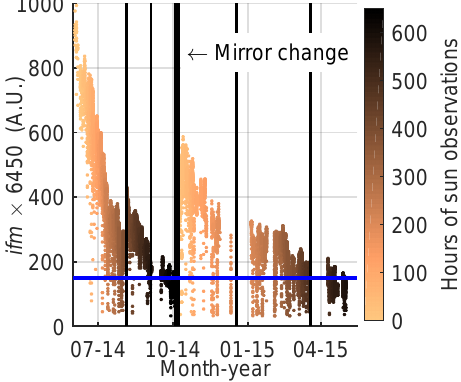
Figure 3. Interferograms from EM27/SUN instruments are nega- tive, with the most negative ordinate values at ZPD and saturation occurring at − 1. Here the interferogram maximums (ifm) refer to the maximum (least negative) ordinate values of the raw interfer- ograms. They were normalized so the maximum is 1000 and are plotted with time showing the loss of signal. These values are af- fected by clouds, which are the cause for much of the scatter. They are also affected by SZA which explains some apparent interme- diate increases. Only every 50th point is plotted for clarity. Mirror cleaning (thin black lines) helped restore some signal, but never to original values. The 150AU line is in